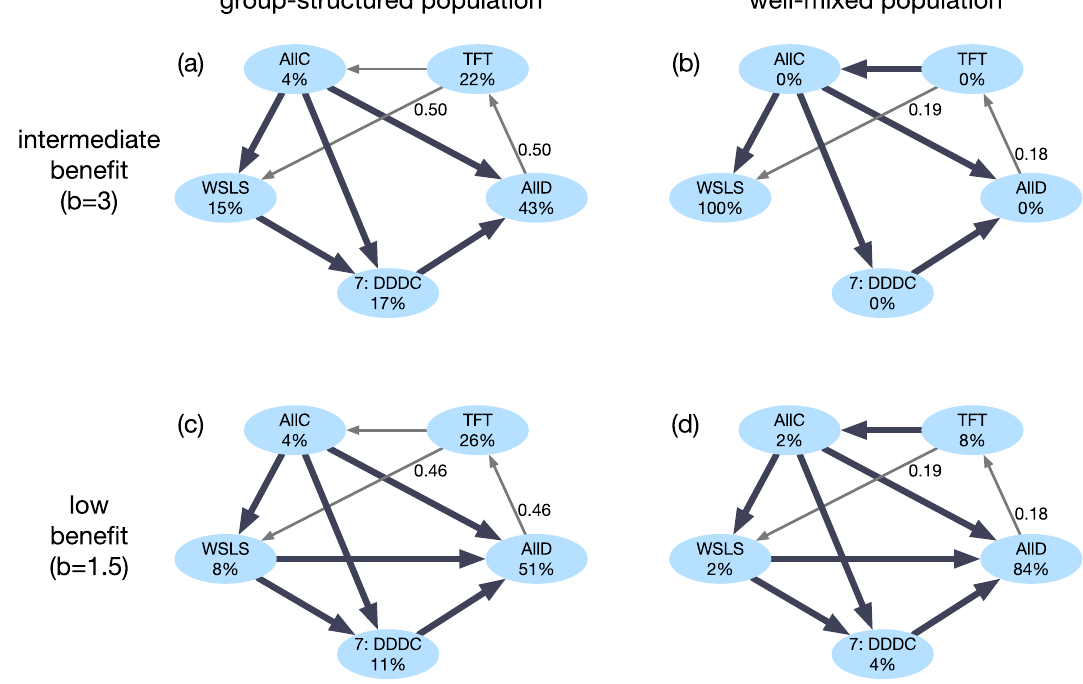
Figure 4. Evolutionary dynamics among five representative strategies when there is a complete separation of time scales. To shed further light on the previous evolutionary results among all memory-1 strategies, here we display the transitions for a reduced strategy set. The reduced strategy set consists of the five strategies AllD, TFT, AllC, WSLS, and S 7 = ( 0, 0, 0, 1 ) . We consider four scenarios, depending on whether the benefit of cooperation is intermediate or low (top and bottom), and depending on whether the population is group- structured or well-mixed (left and right, respectively). Group-structured populations consist of M = 60 groups of size N = 2 ; well-mixed populations consist of a single M = 1 group of size N = 120 . The thickness of the arrows indicates the respective fixation probabilities. Thick arrows without numbers represent cases in which the fixation probability is approximately one. For better clarity, we only depict arrows when the fixation probability is at least 0.1. The numbers represent numerically exact values for a selection strength of σ in = σ out = 10 .